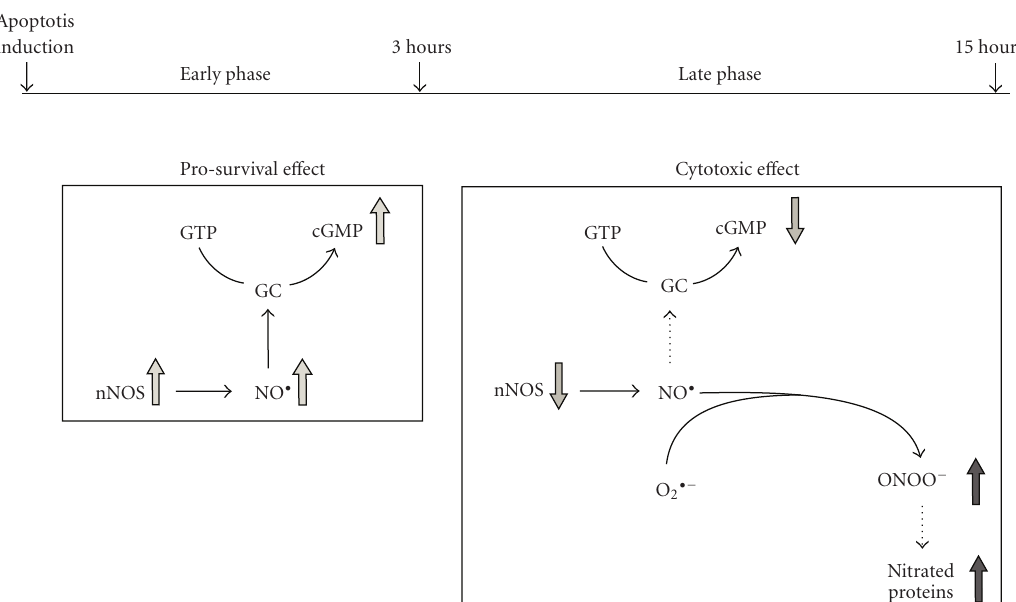
Figure 3: Schematic representation of the time-dependent, dual role of nitric oxide in CGN apoptosis; see text for details. GC , guanylil cyclase; cGMP , cyclic GMP; nNOS , neuronal nitric oxide synthase; O 2 •− , superoxide anion; ONOO − ,